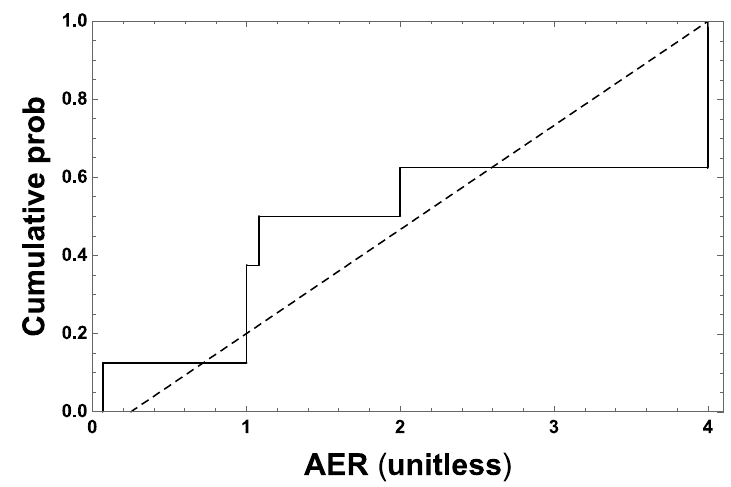
Figure 3. Empirical cumulative distribution of the subset of air exchange rate (AER) values reported for sterilization rooms in the spice sterilization facilities listed in Appendix C-10 of Goldgraben and Zank [16], for which AER ≤ 4/hour, representative of sterilization rooms assumed not to have used forced-air ventilation. The data are consistent with an approximately uniform AER distribution between 0.25 and 4 per hour, as assessed (p = 0.52) by the Kolmogorov one sample test [26].